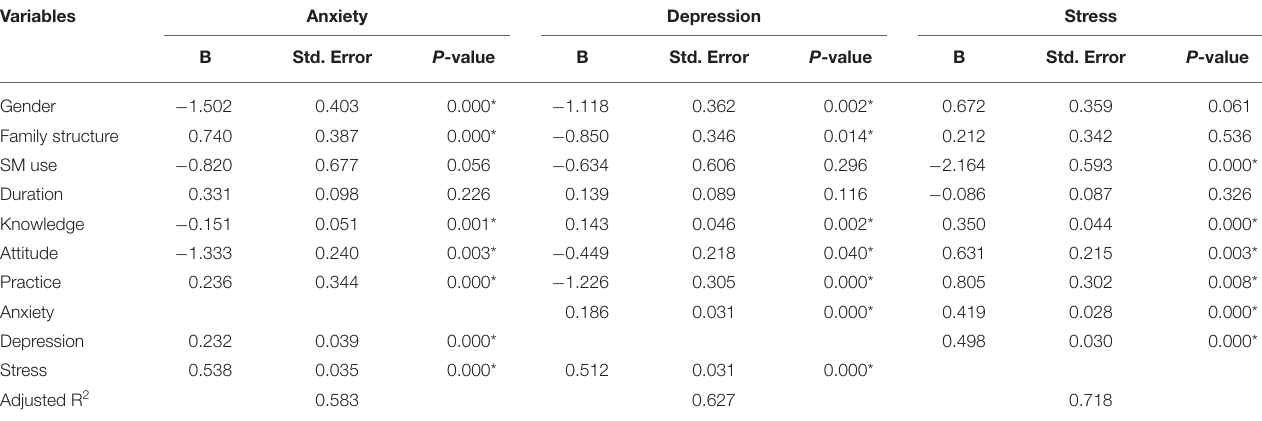
TABLE 4 | Predictors of anxiety, depression, and stress (multiple linear regression